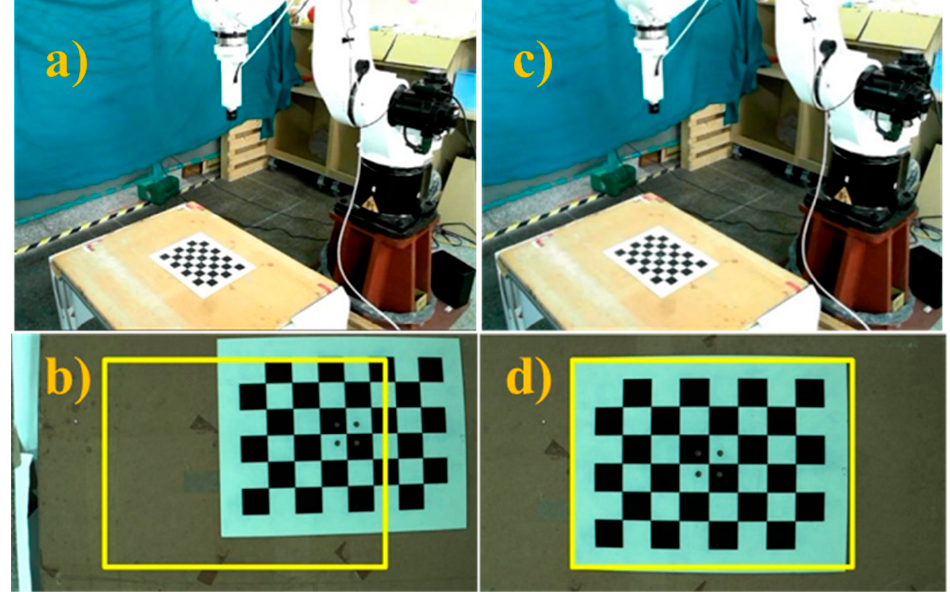
Figure 6. Initial steps of the calibration process. ( a ) Initial robot arm position, ( b ) image captured w.r.t. initial position, ( c ) robot arm position after being manually adjusted, ( d ) image captured after manual adjustment.